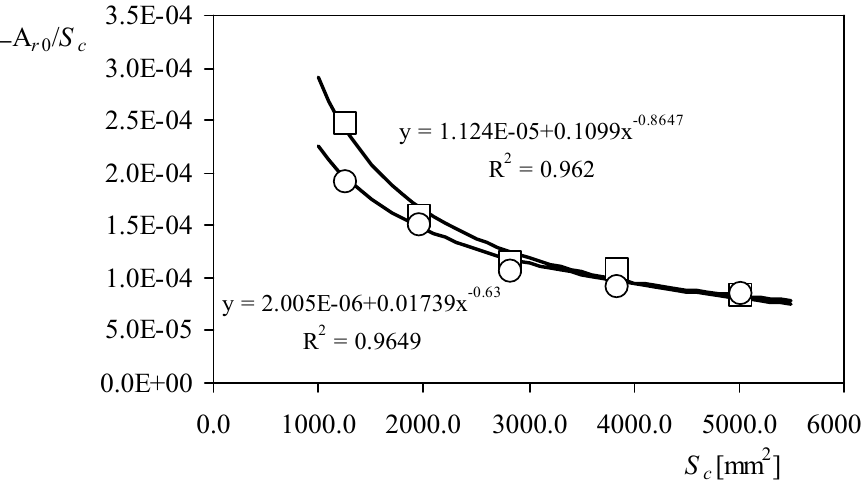
Figure 10. Offset of the linear fittings from Table 2 divided by the cups’ front area, A as a function of the cups’ front area, S (squares) and the Ornytion 107A (circles) anemometers. Power fittings have been also added to the